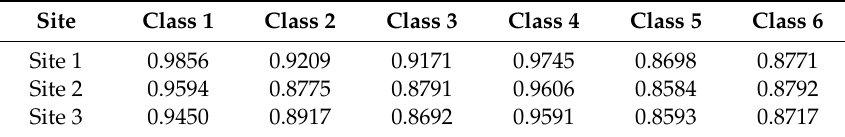
Figure 11. Scatter plots for each class: ( a ) Site 1, ( b ) Site 2 ( c ) Site 3. Table 3. R 2 Values of the predictive models for each class.